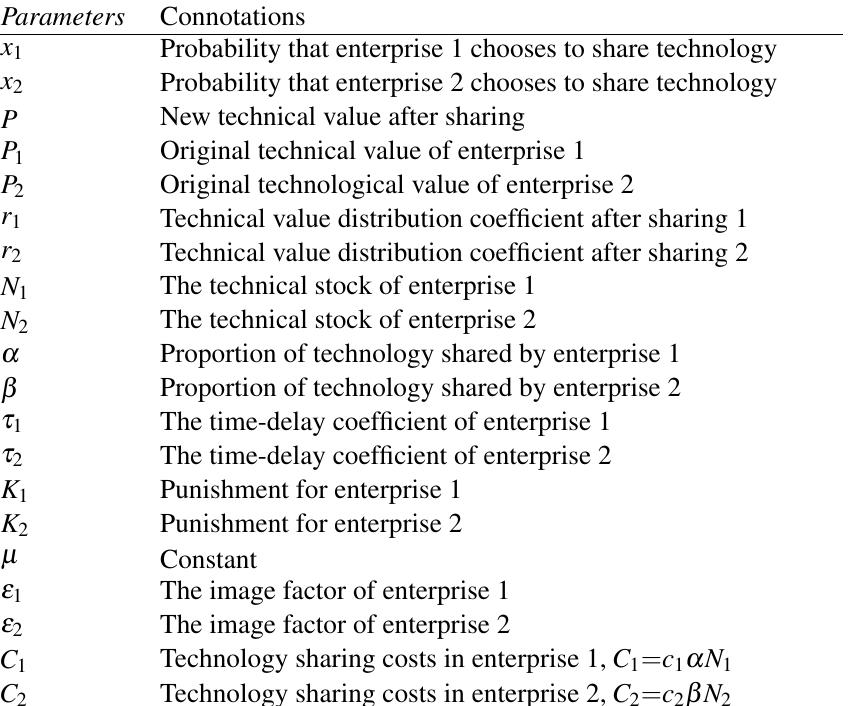
Table 1 Game model parameters and